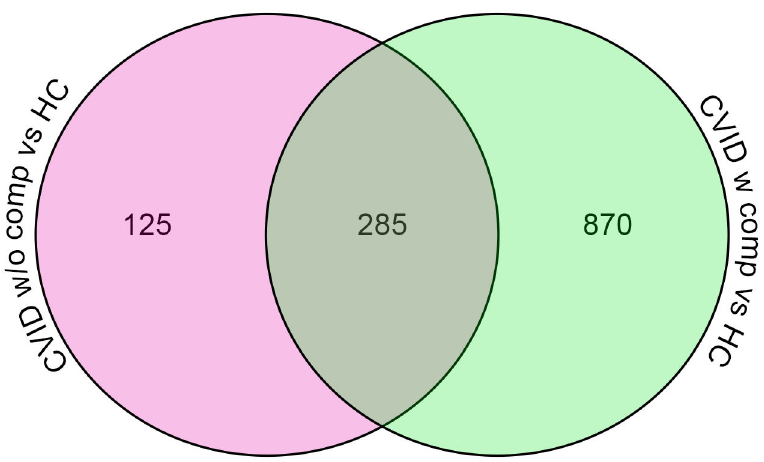
Figure 6. Venn diagram representing the number of common and unique transcripts. Whole blood of subjects with inflammatory complications displayed differentially expressed transcripts as compared to those without such complications or healthy controls.